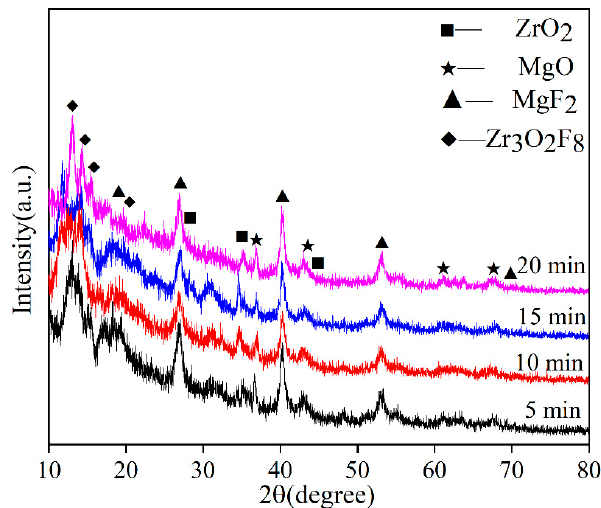
Figure 6. XRD pattern of MAO coatings with different oxidation times.